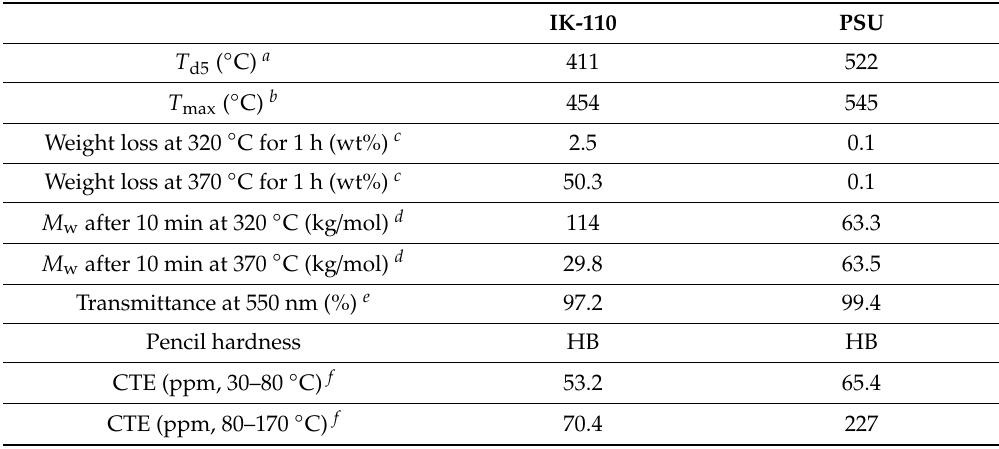
Table 3. Thermal stability, transparency, hardness, and thermal expansion of